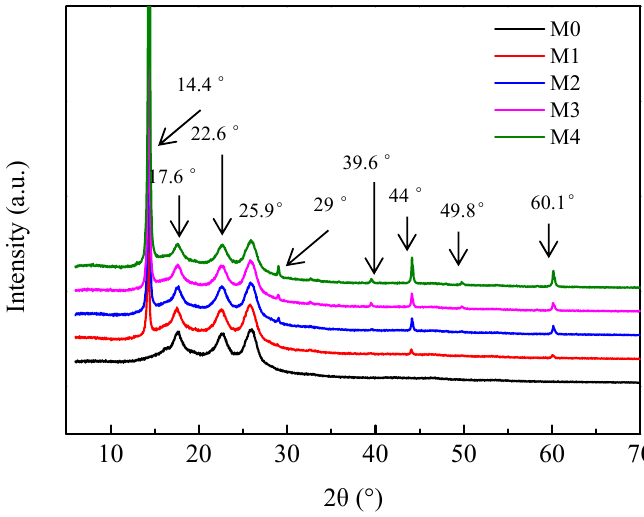
Figure 6. XRD patterns of PES membrane and PES/MoS 2 membranes.